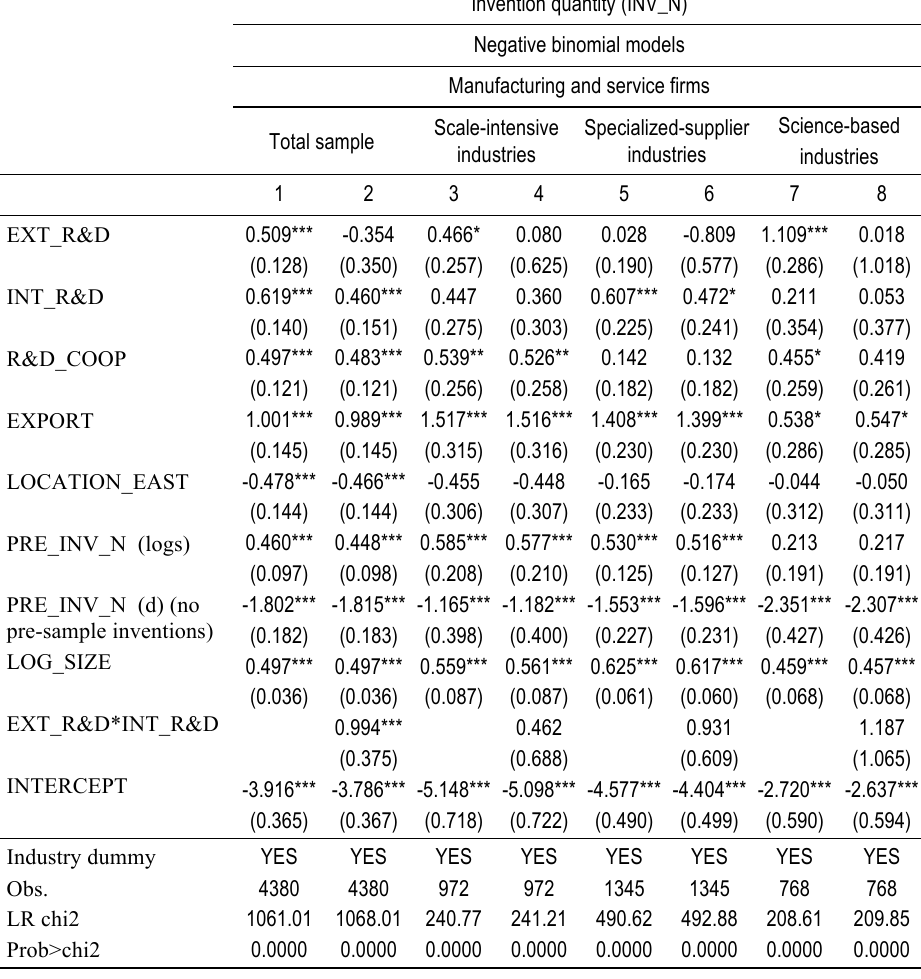
Table 4. Results for invention quantity (manufacturing and service sectors together) Invention quantity